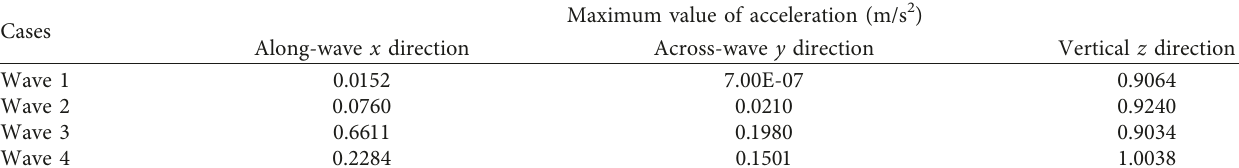
Figure 12: Three-directional acceleration signals of Sensor 7 under Wave 2. (a) Along-wave ( x ) direction. (b) Across-wave ( y ) direction. (c) Vertical ( z ) direction. Table 6: Maximum accelerations from Sensor 7 under various